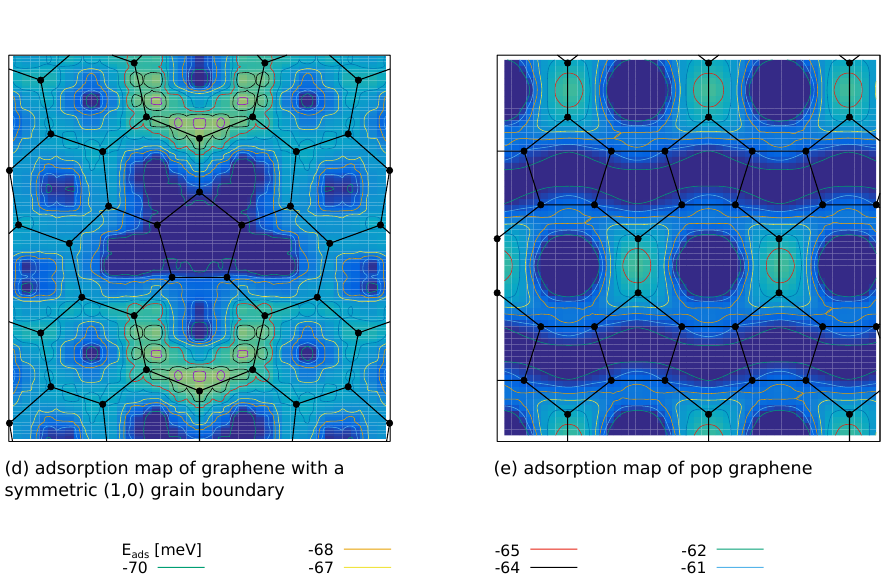
Figure 3. Adsorption maps of various graphene variants. The figures ( a – e ) are all 10 the sampled